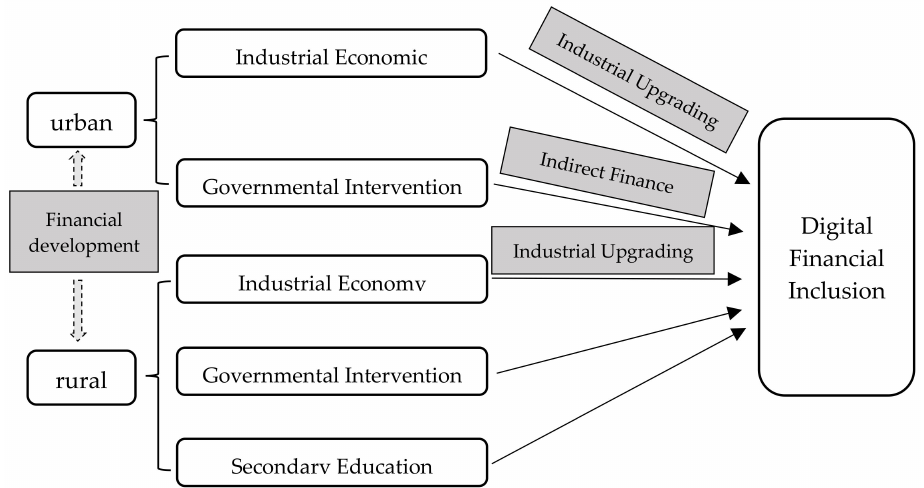
Figure 2. Determinants and mechanisms of digital financial inclusion based on urban and rural